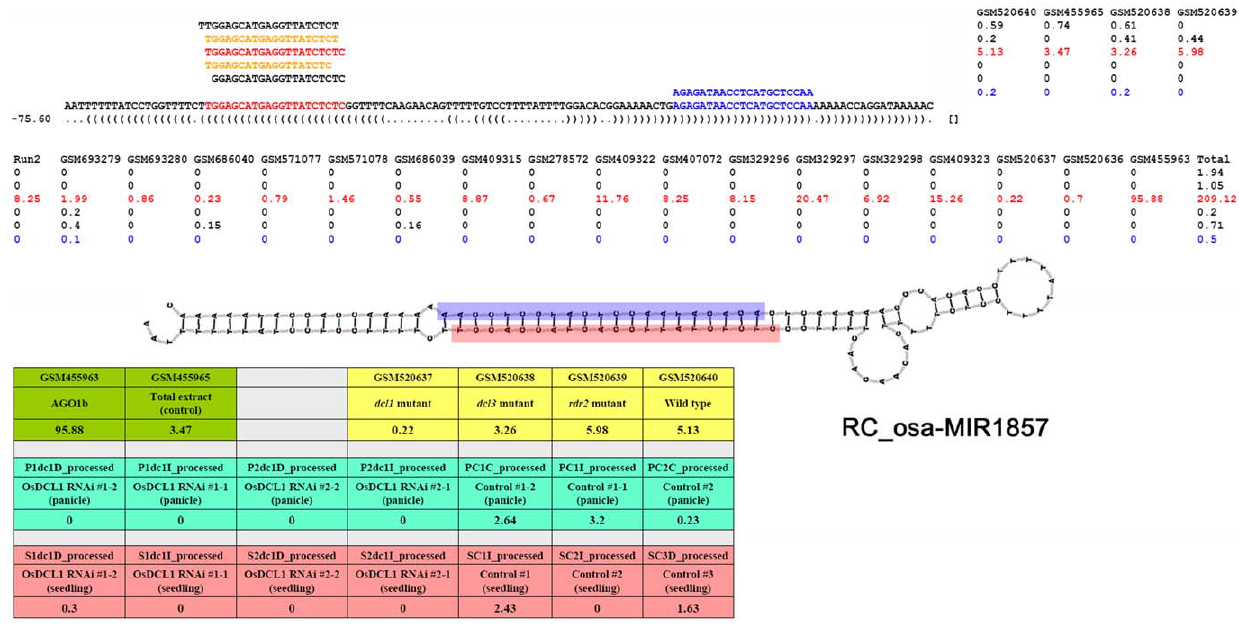
Figure 5. Dependence of RC-osa-miR1857 on DCL1, but not DCL3 and RDR2, and its enrichment in Argonaute 1. Secondary structure and the accumulation levels of the mature RC-miRNA (indicated by red color) and the RC-miRNA* (blue color) are shown on the top of the figure. The table at the bottom shows the accumulation levels of RC-osa-miR1857 in various biological samples, such as wild type seedling, dcl1 mutant, DCL1 RNAi (RNA interference) transgenic lines, dcl3 mutant, rdr2 mutant, and the sequencing data from Argonaute 1 (AGO1)-enriched small RNA population. Please note, the expression data (normalized in RPM, reads per million) was more comparable for the high-throughput sequencing data sets belonging to the same group (indicated by the same background color).